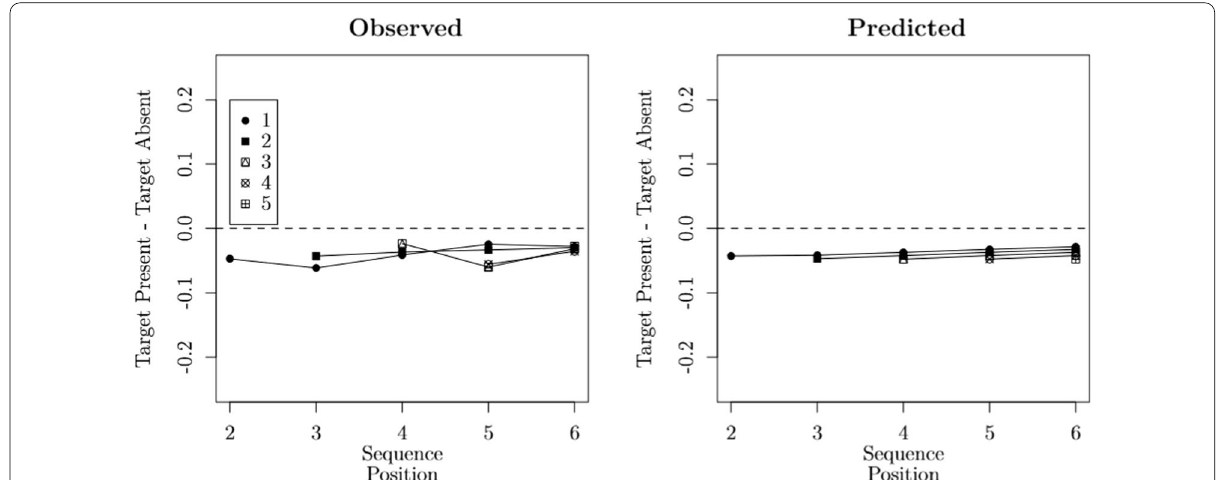
Fig. 15 Differences in the conditional probability of responding “ yes ” in sequence position i between target-present and target-absent lineups. The different symbols distinguish the preceding position taken by the target in target-present